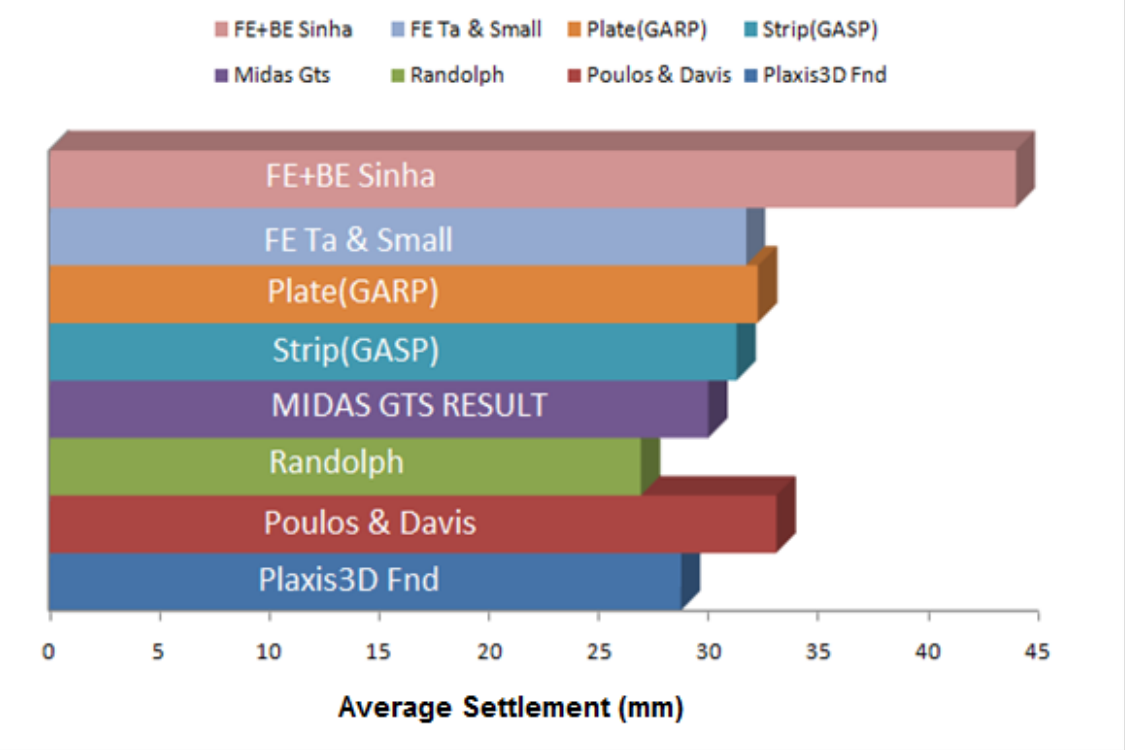
Fig. 16. Comparison of the results calculated using methods with calculated average settlement in MIDAS GTS for Poulos's hypothetical